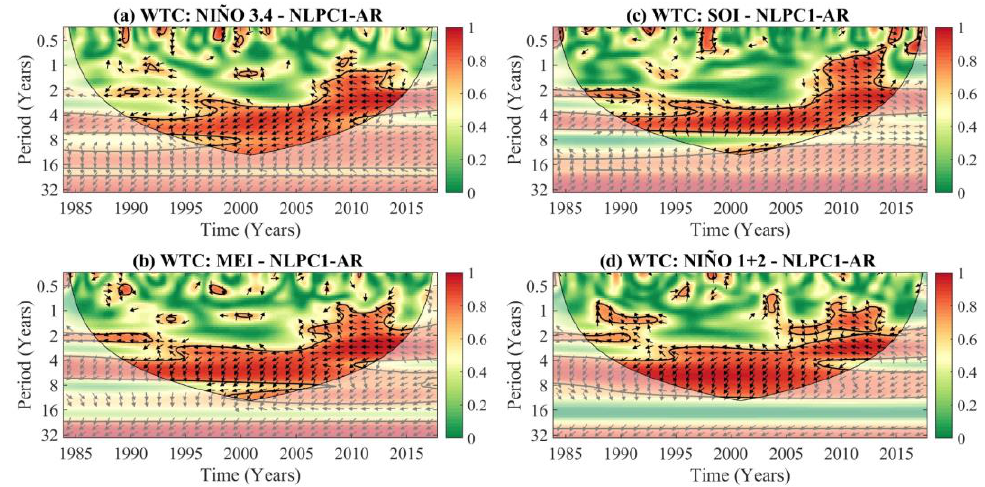
Figure 10. Wavelet transforms coherence between the NLPCs series of AR and climate-oceanographic indices: NLPC1-AR ( a ) Niño3.4, ( b ) MEI, ( c ) SOI, and ( d ) Niño1 + 2 (NLPC2-AR). The closed contours indicate the squared Wavelet Coherence. The region where the edge effects are significant is under the cone of influence. The arrows denote phase differences: in-phase (0°), arrows point out to the right; out of phase (180°), arrows point out to the left; the first-time series leads the second by 90°, pointing down; and, the first-time series, the second one by 90, pointing upwards.